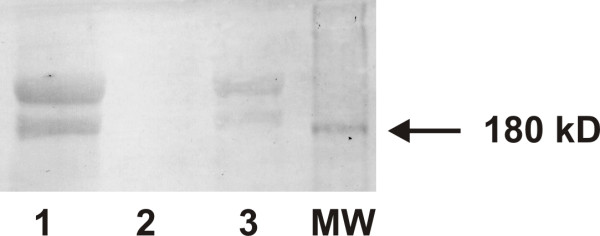
Western Blot analysis of circulating immune complexes' fractions eluted and isolated from affinity chromatography. Circulating immune complexes were obtained from a patient with a stage IV larynx tumor. Lane 1: 3.5% PEG precipitate; lane 2: PBS eluate from protein A Sepharose CL-4B column and lane 3: glycine HCl eluate. In lanes 1 and 3 a double band at about 200 kD is observed.